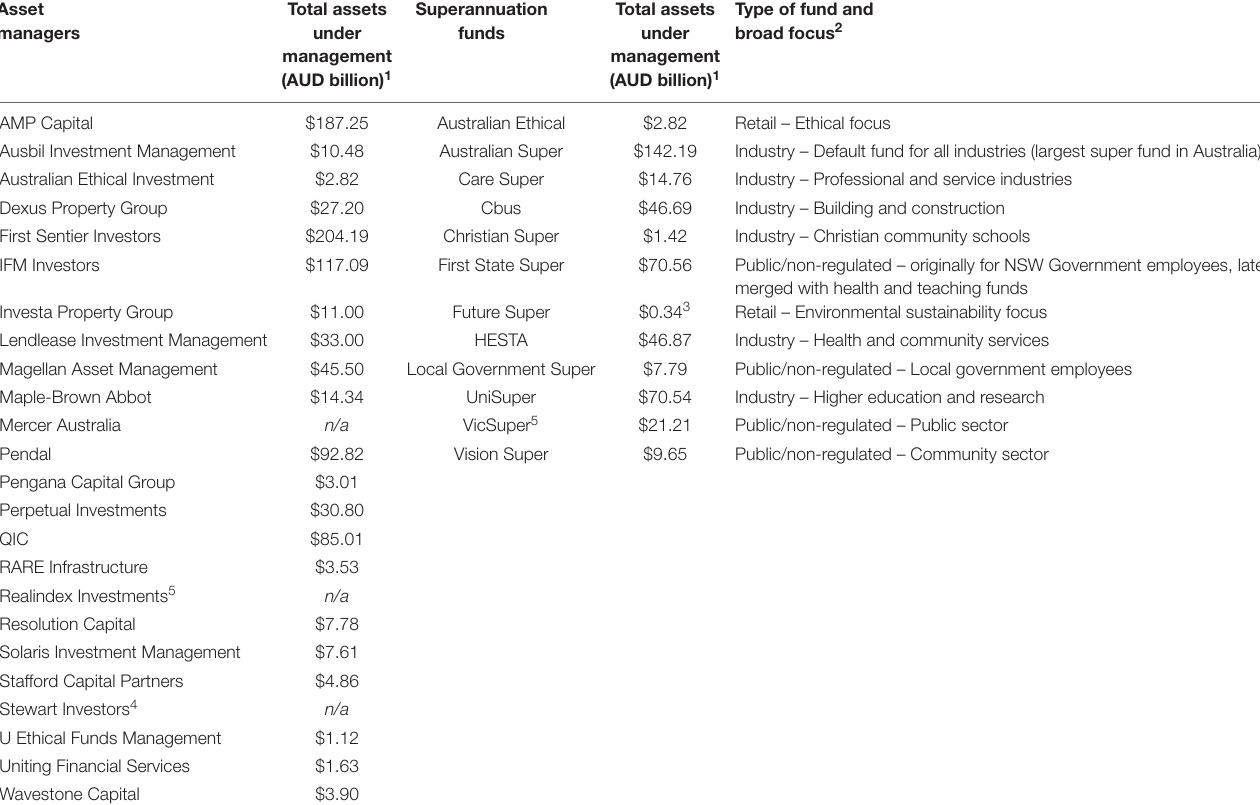
TABLE 2 | Characteristics of asset managers and superannuation funds included in the sample, as at